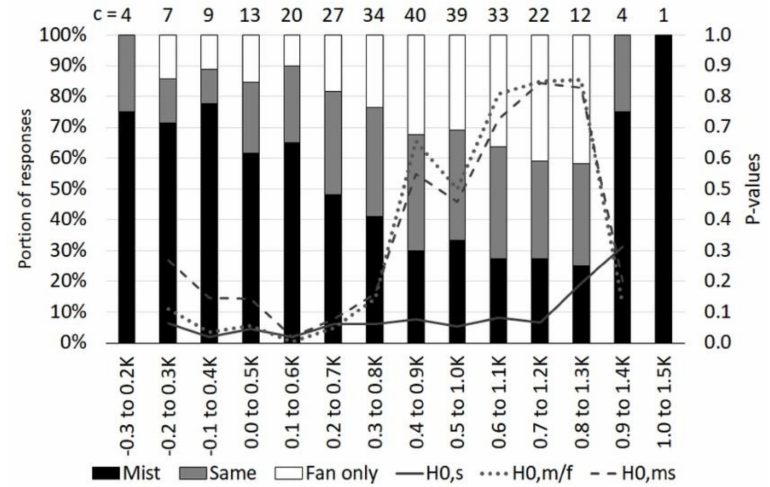
Figure 9. Proportion of responses on which air stream felt cooler in a rolling evaluation of 0.5 K bin width steps. Responses from the third experiment trial.